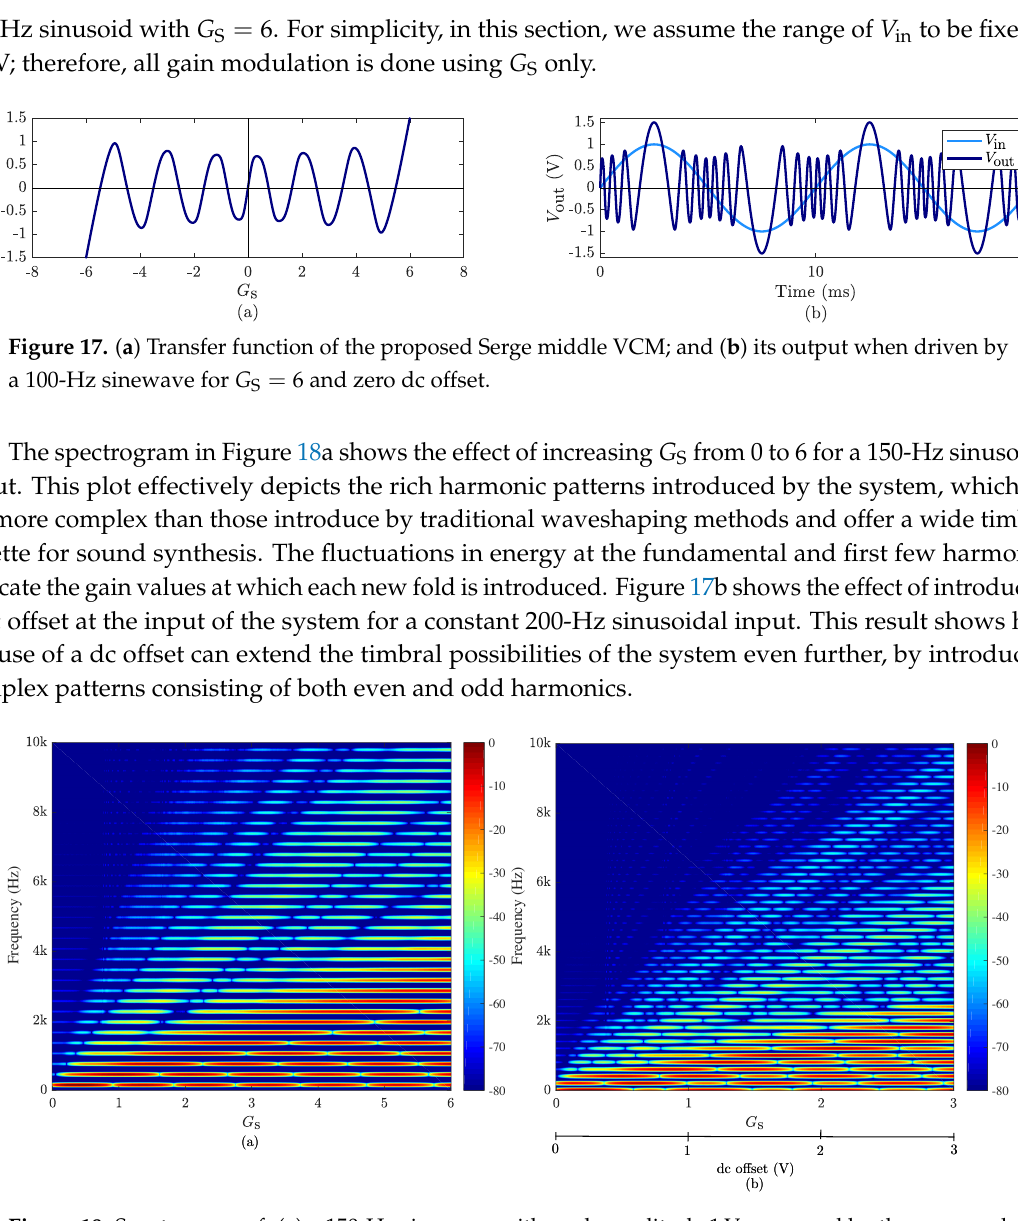
Figure 18. Spectrogram of: ( a ) a 150-Hz sinewave with peak amplitude 1V processed by the proposed Serge middle VCM with varying gain G S from 0–6; and ( b ) a 200-Hz sinewave processed with varying gain G S from 0–3 and dc offset from